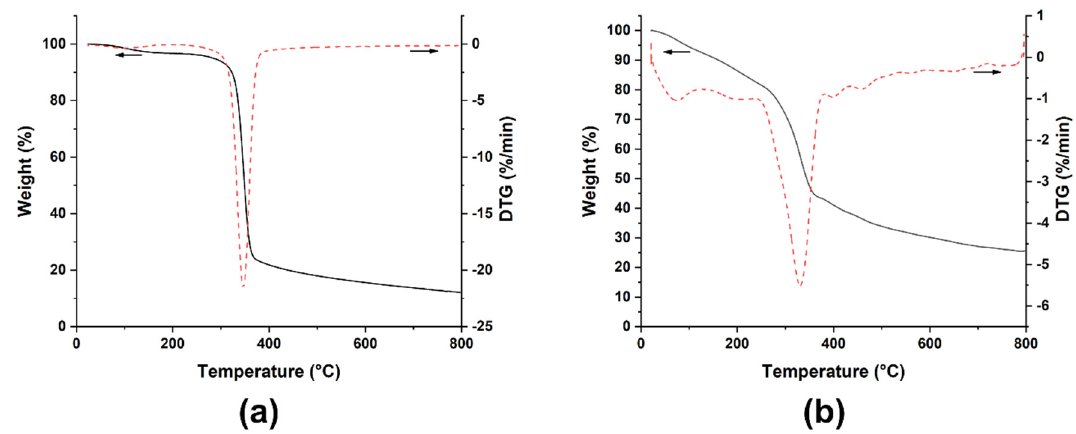
Figure 7. TGA (black solid curves) and dTG (red dot curves) thermograms of ( a ) neat flax yarns and ( b ) ZnO-coated flax yarns (arrows indicate the corresponding Y axis). ( b ) ZnO-coated flax yarns (arrows indicate the corresponding Y